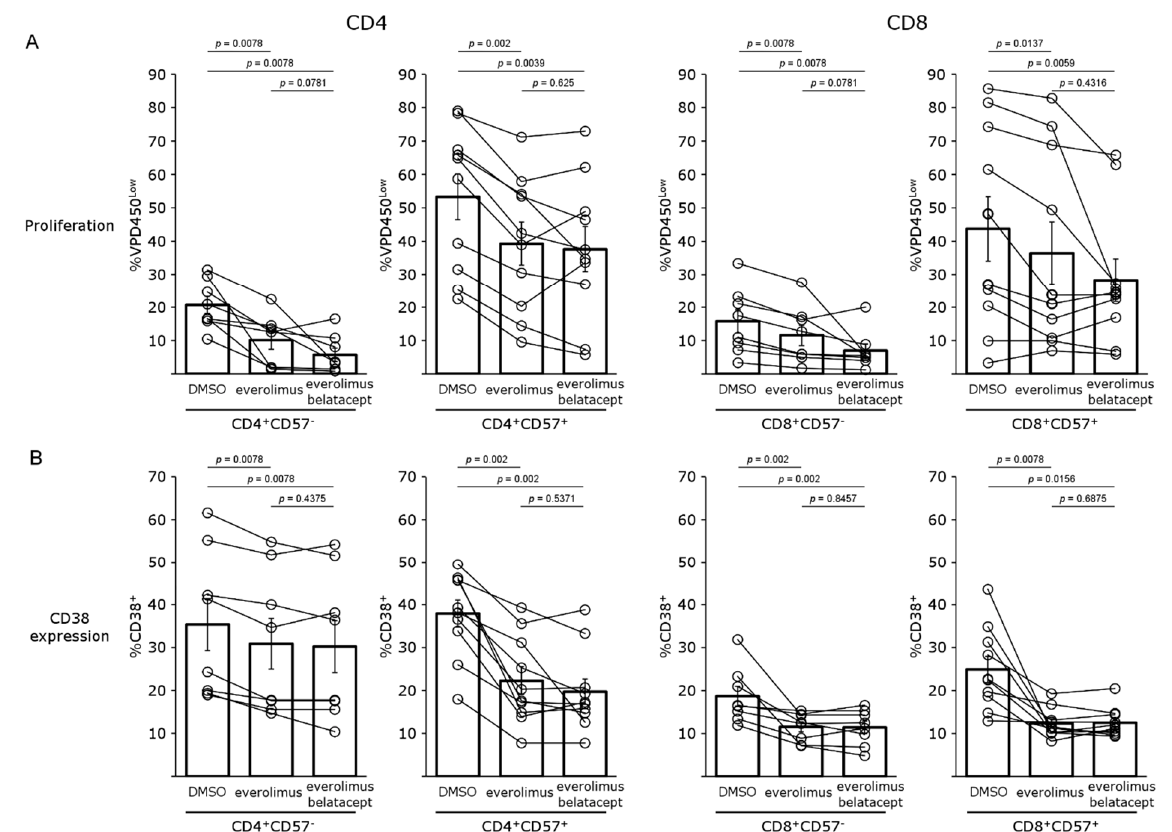
Figure 4. Activation and proliferation of CD4 + CD57 − , CD4 + CD57 + , CD8 + CD57 − and CD8 + CD57 + T cells in the presence of mTOR inhibitor: ( A ) Proliferation and ( B ) CD38 expression of CD4 + CD57 − , CD4 + CD57 + , CD8 + CD57 − and CD8 + CD57 + T cells after 5 days of culture with allogeneic aDCs without (DMSO) or with everolimus, or everolimus + belatacept. Eight (CD57 − ) or ten (CD57+) independent experiments (pictograms) were performed, and the mean (bar chart) and SEM are shown. CD4 + CD57 + cells have been shown to be cytotoxic and to express granzyme B (GrzB). As previously described, more than 50% of CD4 + CD57 + T cells and more than 45% of CD8 + CD57 + T cells expressed GrzB, whereas the percentage of cells expressing GrzB was below 12% for CD4 + CD57 − T cells and 20% for CD8 + CD57 − T cells. Everolimus decreased